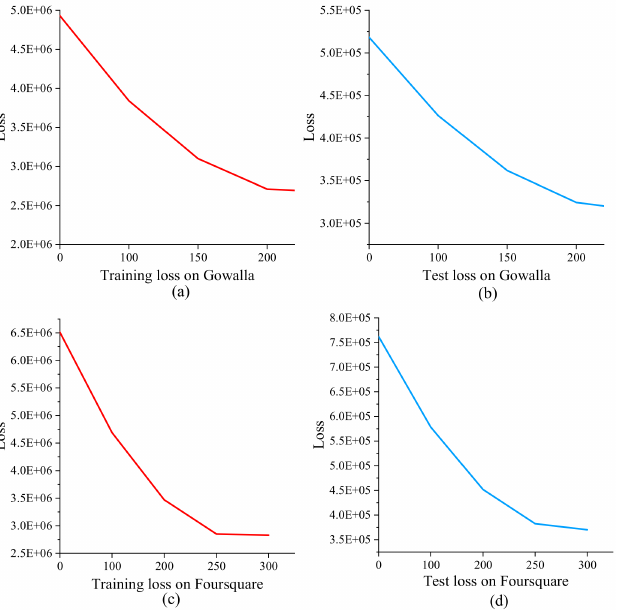
Figure 10. Training and test loss of BiTCF@: ( a , b ) on Gowalla; ( c , d ) on